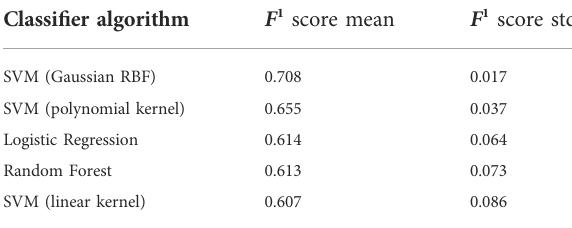
TABLE 1 Comparison between various classi fi cation algorithms in combination with